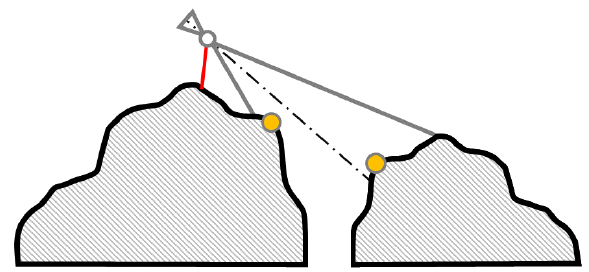
Figure 3. Measurement configuration. The camera (gray circle) mounted on a stick (red line) is oriented in a way, that both edges (yellow dots) of the crevice are visible.